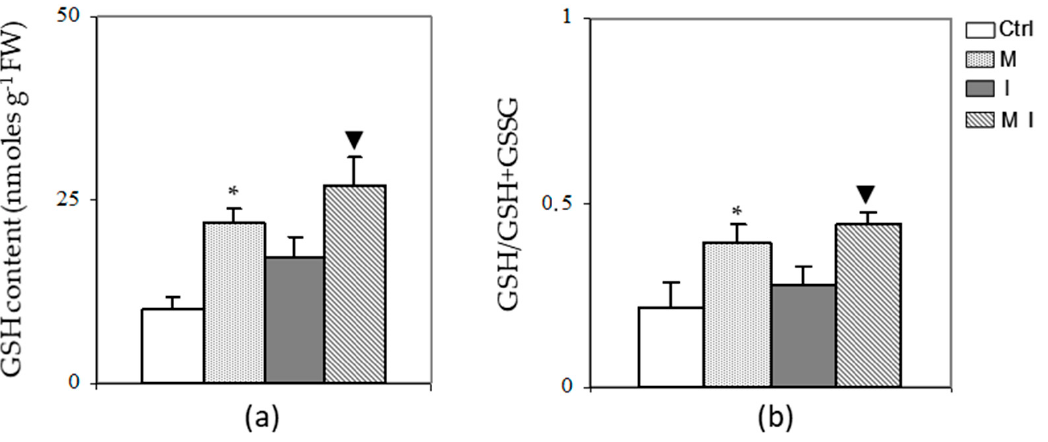
Figure 2. Glutathione (GSH) content ( a ) and glutathione redox ratio ( b ) in artichoke control plants (Ctrl), in mycorrhizal plants (M), in plants inoculated with Verticillium dahliae (I), and in mycorrhizal plants inoculated with V. dahliae (MI). The results are given as the mean values of at least five experiments ± SD; * indicates values significantly different from the control (Ctrl) by the Student’s t test with p < 0.05; ▼ indicates values significantly different from the artichoke inoculated with V. dahliae (I) by the Student’s t test with p < 0.05. FW, fresh weight.